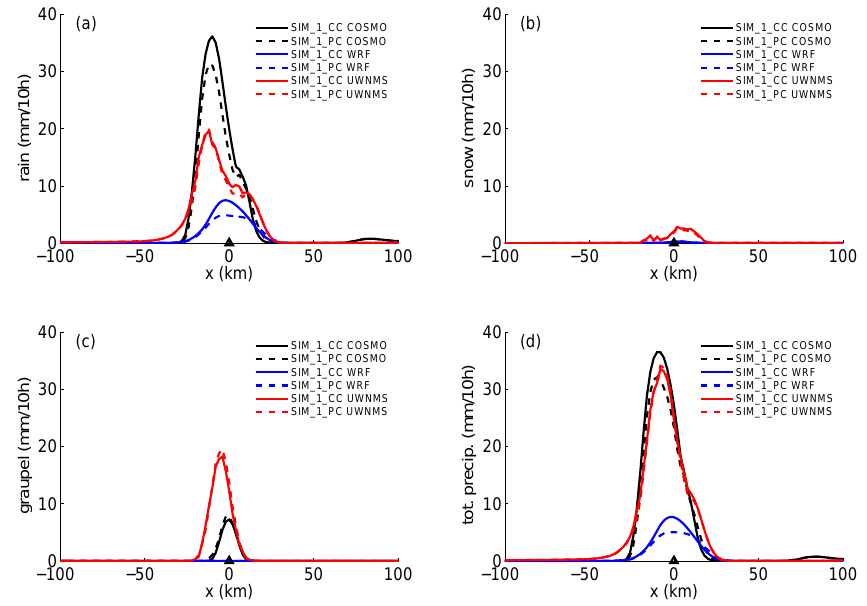
Fig. 9. Orographic precipitation distribution for the simulations SIM 1 CC (solid) and SIM 1 PC (dashed) for rain (a) , snow (b) , graupel (c) and total precipitation (d) after 10h simulation time. The individual models shown are COSMO (black), WRF (blue) and UWNMS (red).